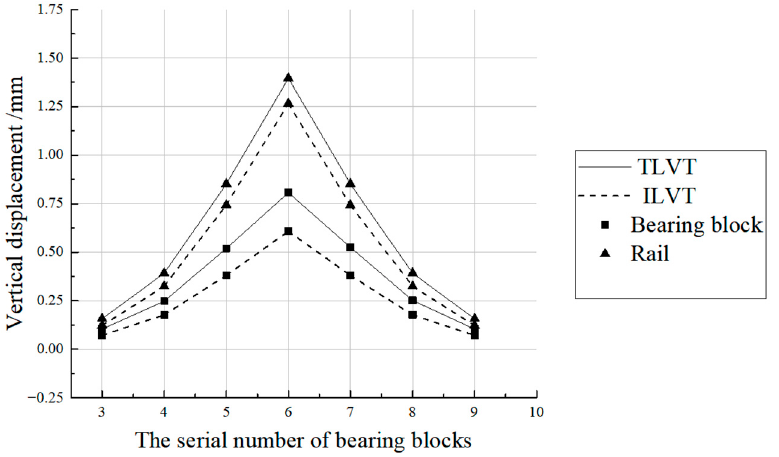
Figure 15. The vertical displacement of the rail and bearing block in Working Condition 1.